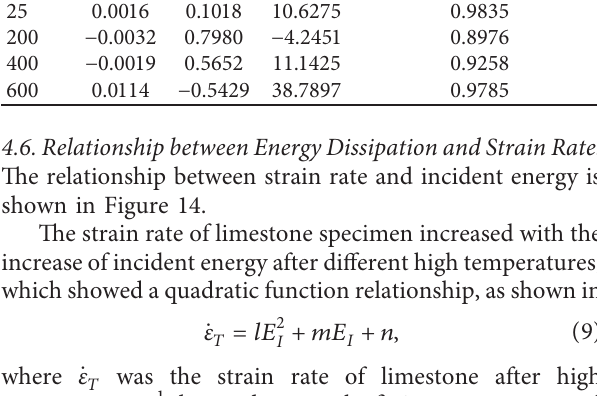
Table 4: Parameter values of strain rate and incident energy. T ( °